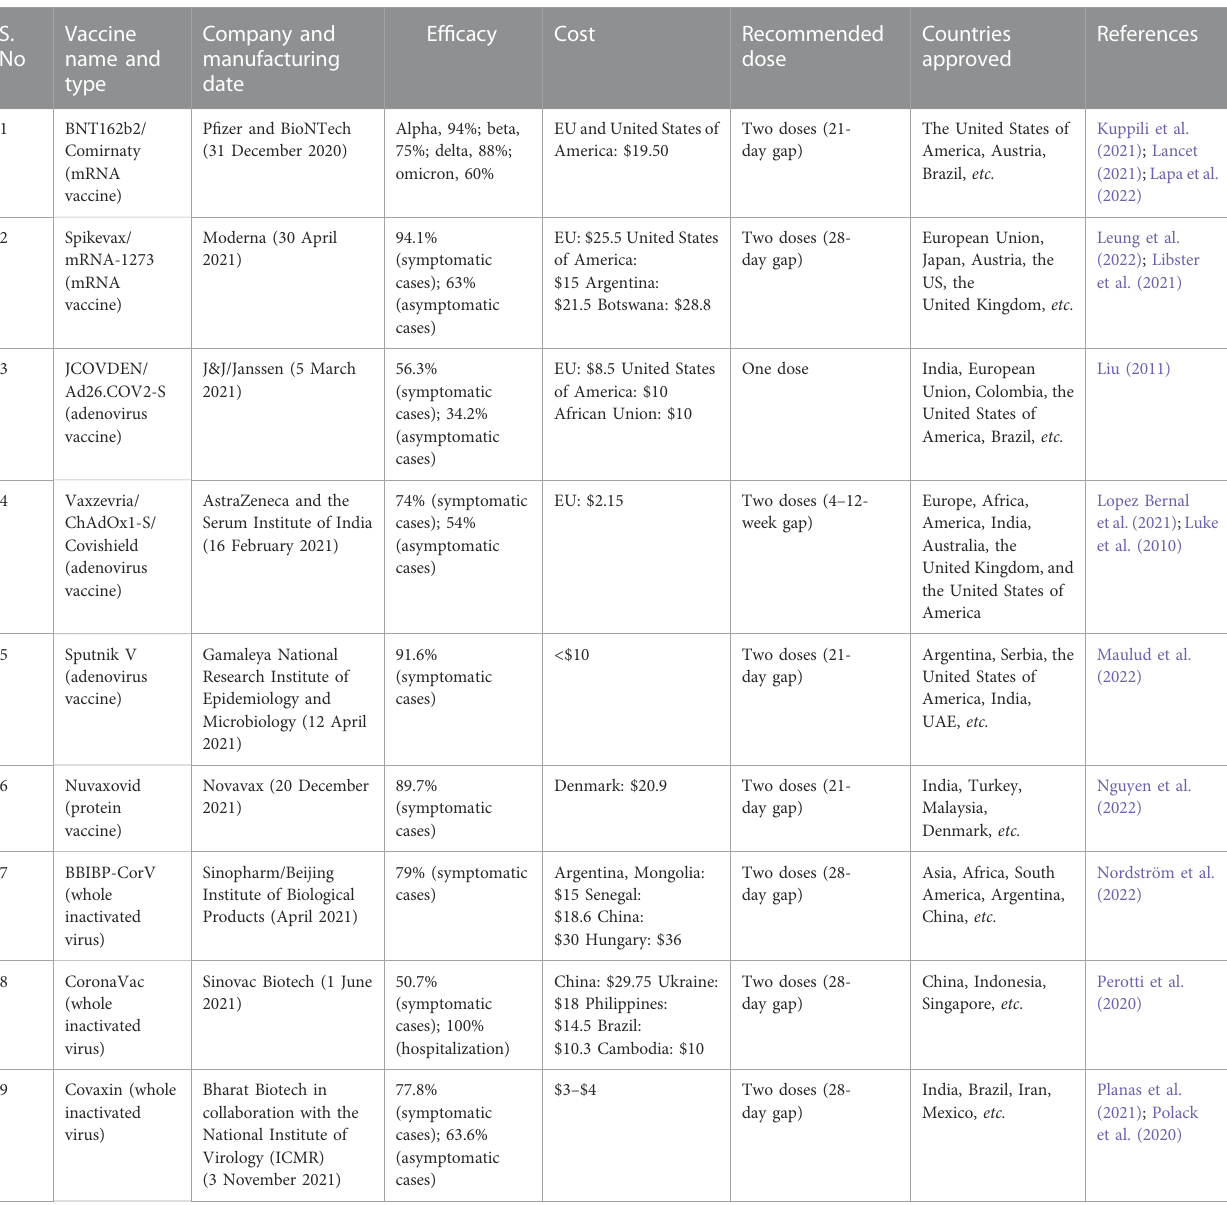
TABLE 1 Comparison of the different types of widely used vaccines